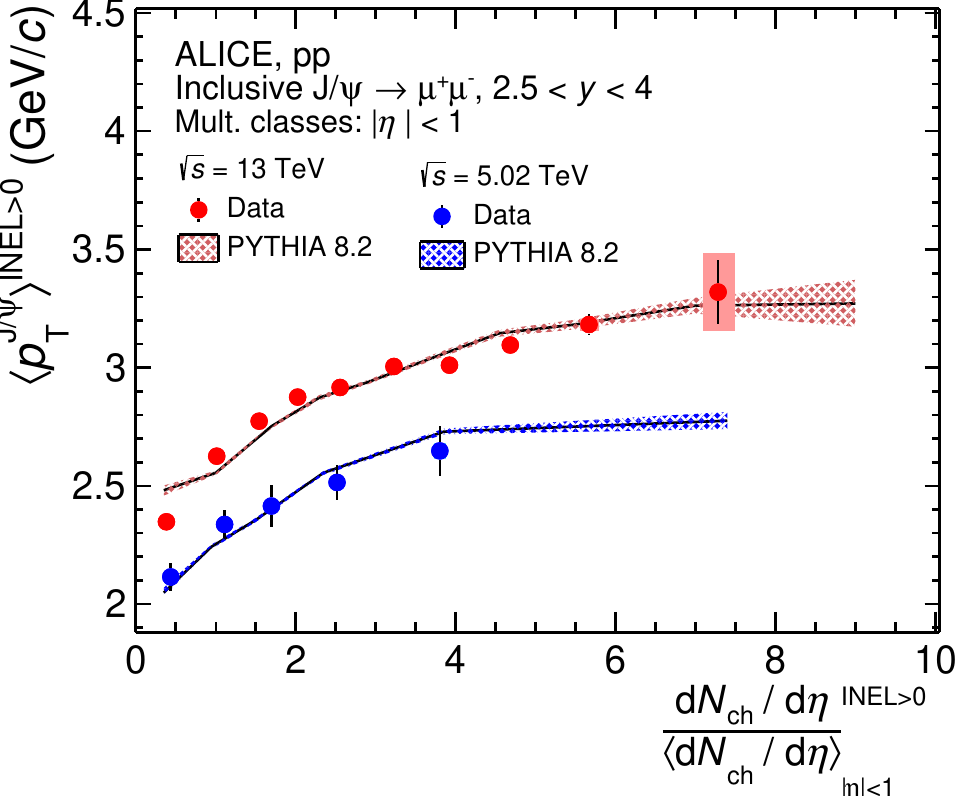
Figure 8 . Comparison of forward rapidity h p J /ψ i as a function of the relative charged-particle T √ density in pp collisions at s = 5.02 and 13 TeV with PYTHIA 8.2